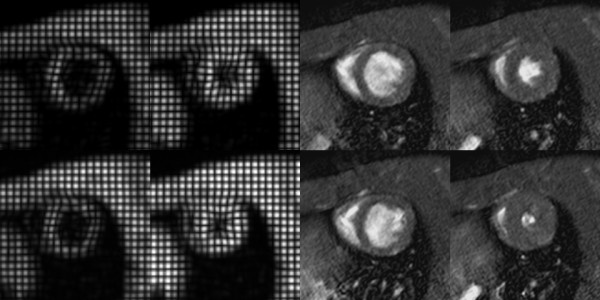
Representative example of tagged and cine CMR at rest (first row) and stress under 5 μg/min/kg of dobutamine (2nd row) in diastolic and systolic phases obtained in normal heart. The effect of both the increase of wall thickening and the decrease of the LV end-systolic volume are clearly seen on the CMR images.